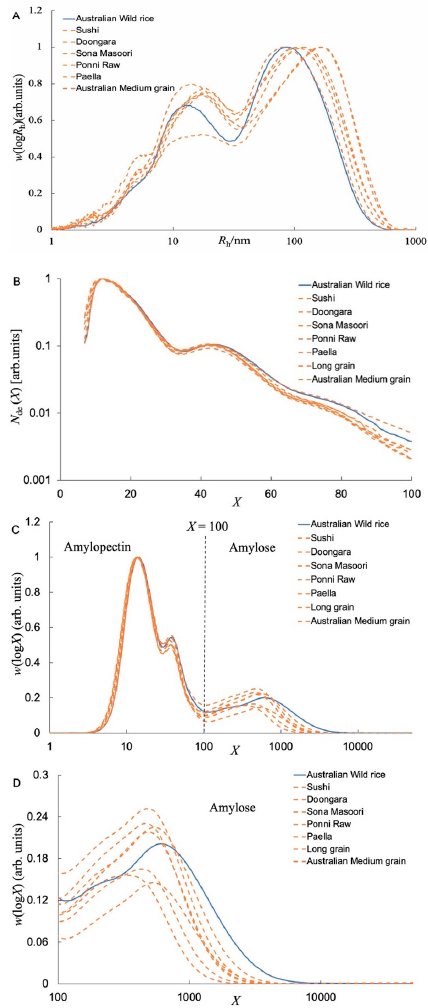
Figure 2. ( A ) SEC weight distributions, w (log R h ), of whole (branched) starches extracted from both AWR and CRs as a function of molecular size R h , normalized to the maximum of Ap component. ( B ) The starch CLDs characterized by FACE plotted as N de ( X ) against DP X (FACE produces discrete points for each DP, but, for visual ease, these are plotted as continuous lines.). ( C ) The starch CLDs characterized by SEC plotted as w (log X ) against DP X , normalized to the maximum of the Ap component. ( D ) Enlargements of the Am regions of the CLDs. All data are averages of duplicate measurements.